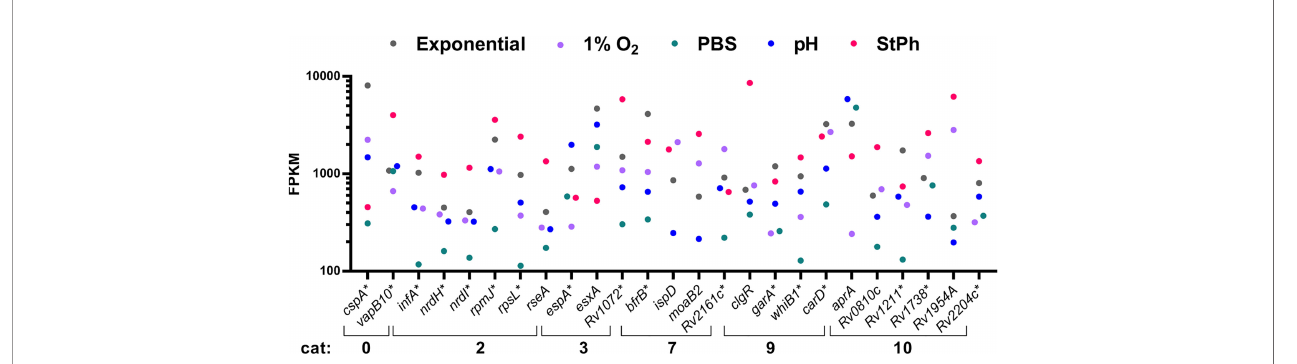
FIGURE 7 | Fragment per kilobase million (FPKM) of genes in the 95 th percentile. The fi ve M. tuberculosis growth conditions were: exponential, hypoxia (1% O 2 ), nutrient starvation (PBS), acidic environment (pH) and stationary phase